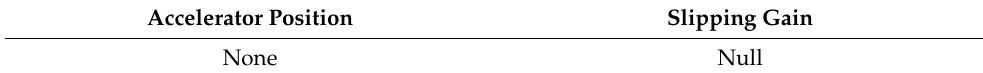
High Table 2. ICE speed laws. ICE Speed Rate High Table 3. Driver intention laws. Accelerator Position